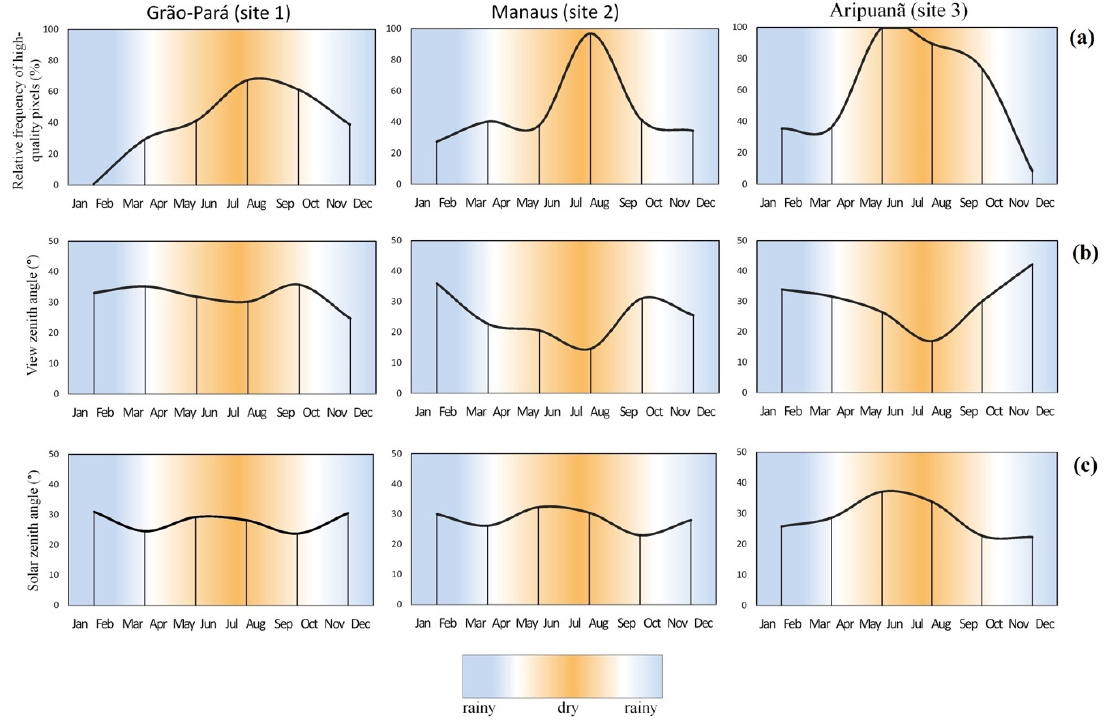
Figure 2. Seasonal variations in the ( a ) relative frequency of high–quality pixel retrievals, ( b ) view zenith angle (VZA), and ( c ) solar zenith angle (SZA) for the three sites selected from north to south of the Amazon. The location of the sites is indicated in Figure 1. Results refer to 2008, a non–drought year.